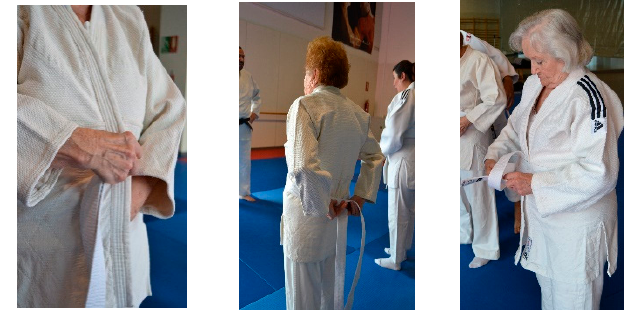
Figure 3. Belt positioning sequence.